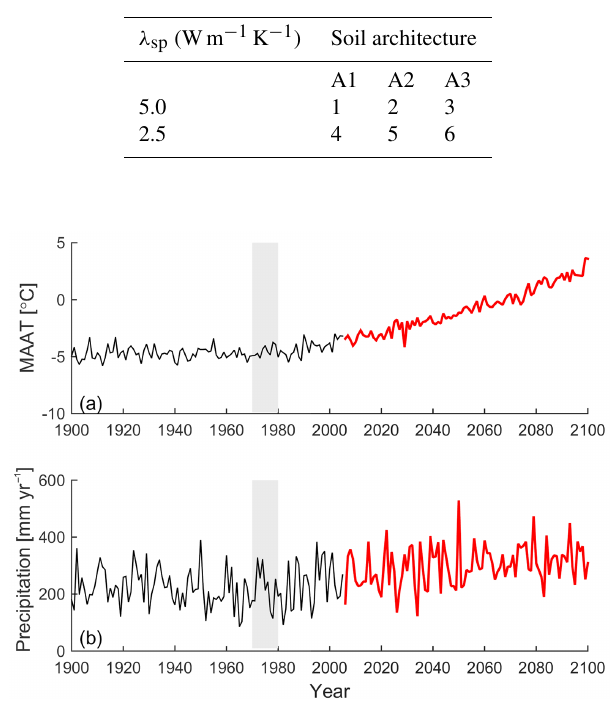
Table 2. Six simulations with different combinations of soil archi- tecture and thermal conductivity of soil particles ( λ sp ) for the shal- low soils (0–3.0m). A1, A2 and A3 stand for three types of soil architecture in Table 1.